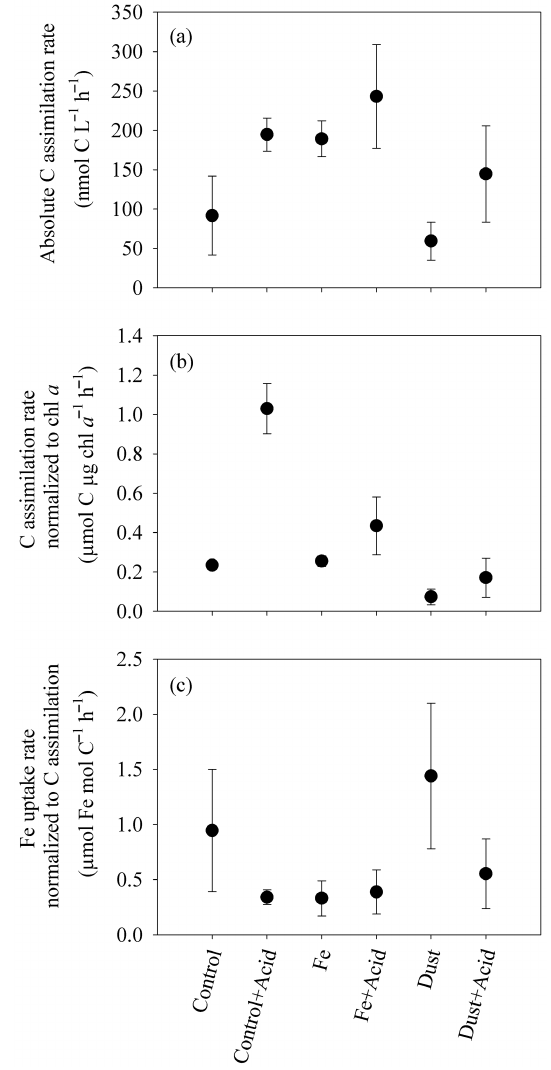
Figure 4. Average (a) absolute C assimilation rates. C assimilation rates normalized to chl a concentration at T4 ( (b) ) and Fe uptake rates normalized to chl a concentration at T4 ( (c) ). Error bars in- dicate standard deviations. Absolute C assimilation rates: n = 3 ex- cept Control and Acid, where n = 2; C assim norm to chl a : n = 3 except Control, Acid, and Dust + Acid, where n = 2; Fe uptake rates normalized to chl a : n = 3 except Control and Dust + Acid, where n =